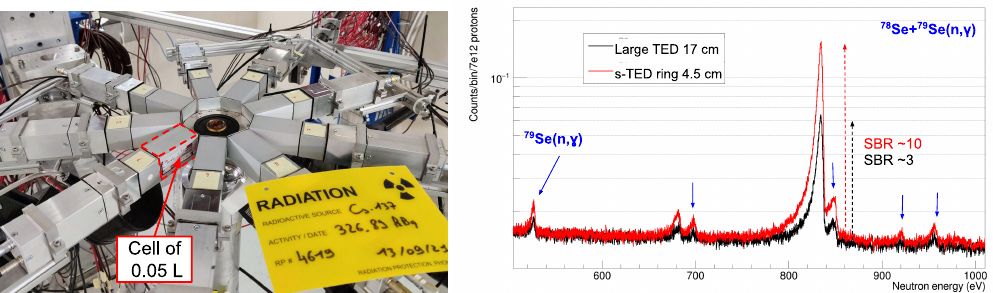
Figure 3. Left: s-TED detector cells in the innovative ring configuration used in EAR2 (right). Right:(n, γ ) counting rate measured at EAR2 with the PbSe( 78 + 79 Se) sample in beam using 2 large C 6 D 6 detectors (black) and 9 s-TED cells in ring configuration